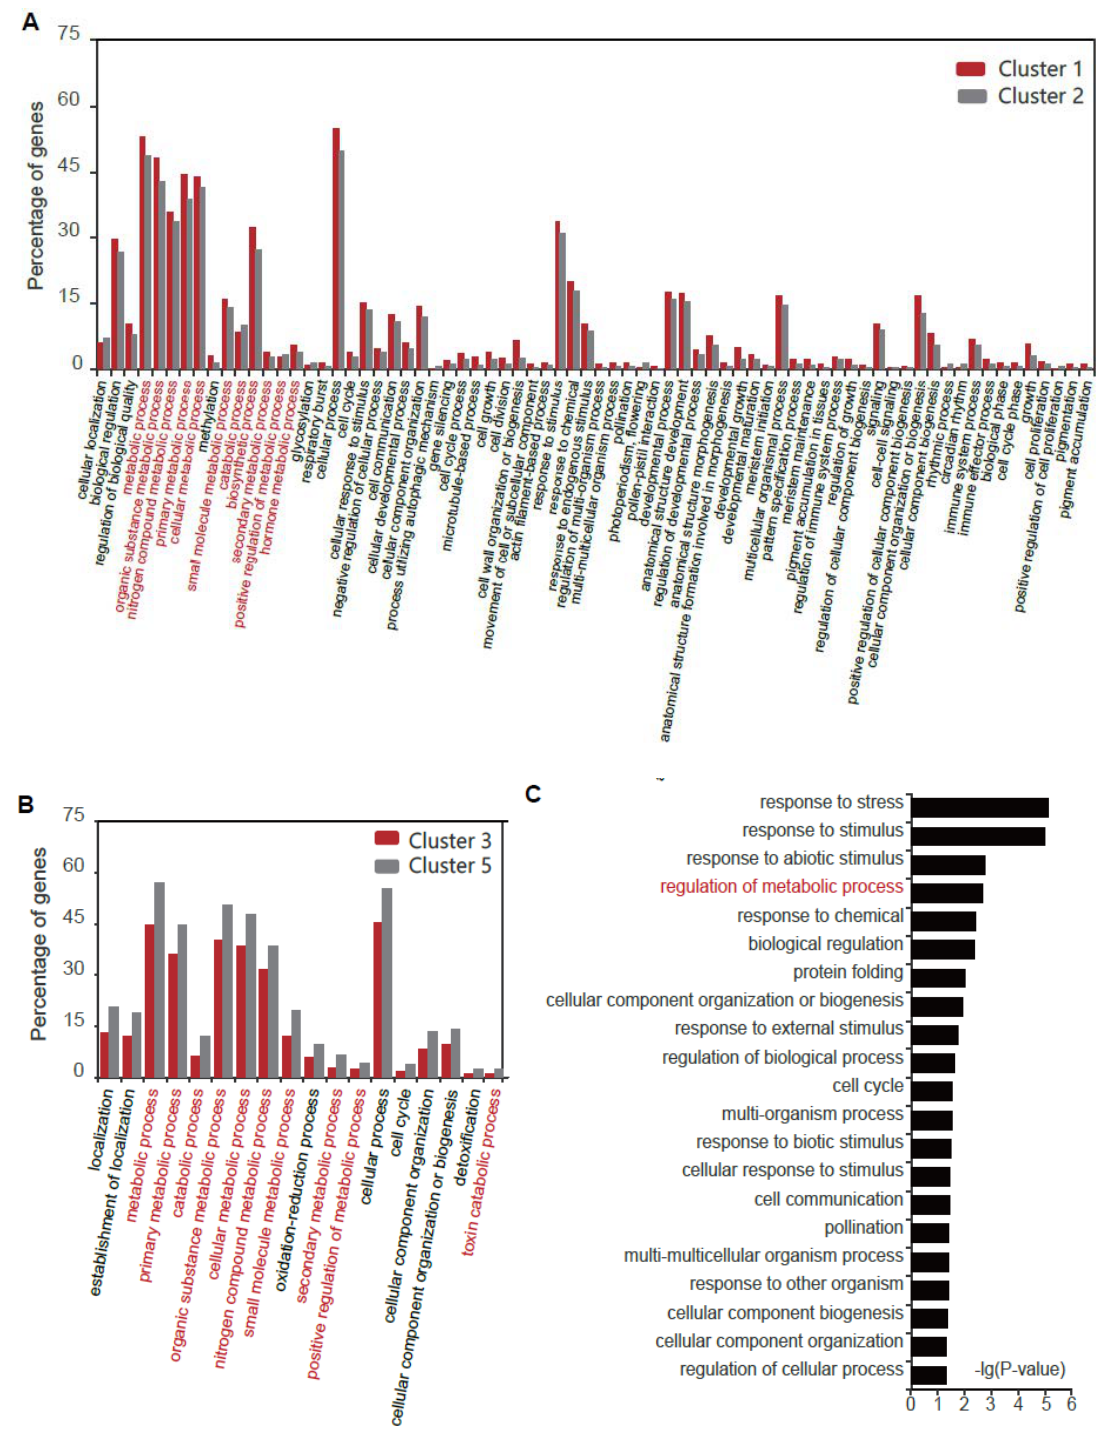
Figure 4. The comparison of GO for different clusters showed distinct functional differentiation. ( A ) GO term comparison for clusters 1 and 2. ( B ) GO term comparison for clusters 3 and 5. ( C ) GO term for genes in clusters except clusters 1–3 and 5. The GO terms related to metabolism in ( A – C ) are marked in